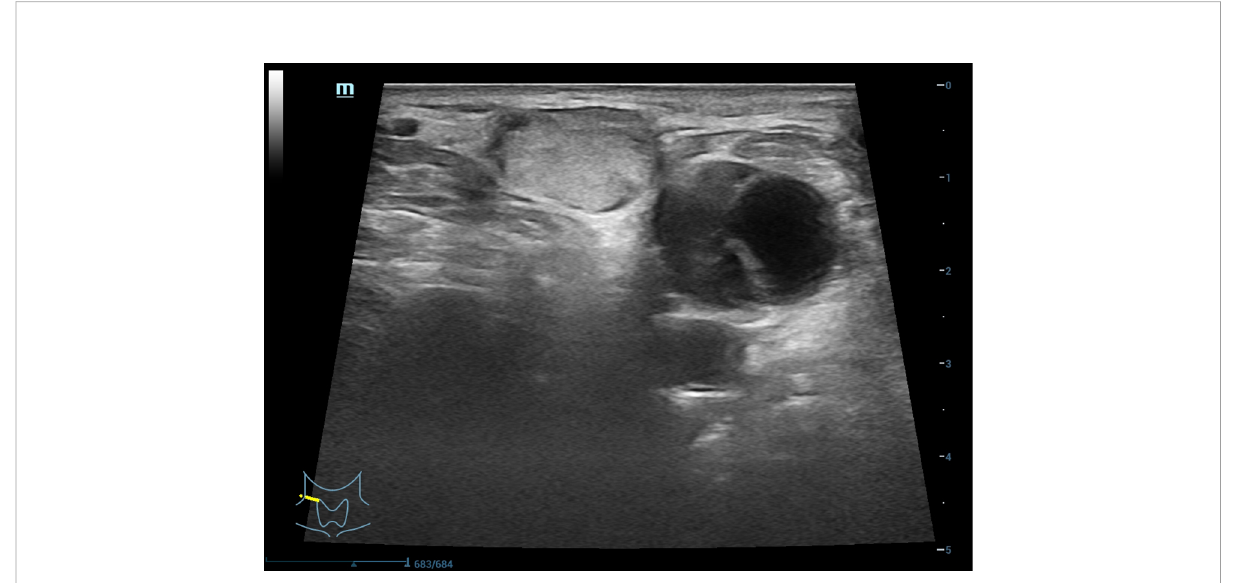
FIGURE 4 Right cervical lymph node